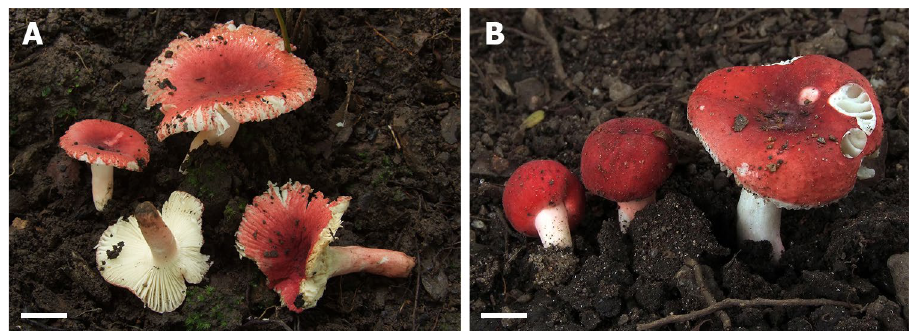
Figure 3. Basidiomata of Russula bellissima . ( A ) FH12-127 (Holotype). ( B ) FH12-158. Scale bar = 1 cm. Photos by Felix Hampe.